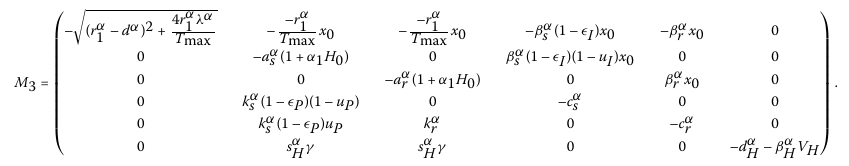
The linearization matrix of model (1) around the disease-free equilibrium, P 0 ,